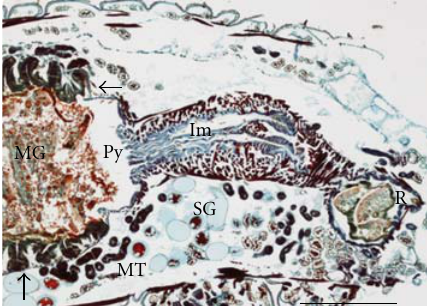
Figure 13: Longitudinal section (dorsal side up) of a N. abietis larva showing folds (arrows) in the epithelium at posterior end of the midgut (MG) and the hindgut showing the pylorus (Py), ileum (Im), and rectum (R). Malpighian tubules (MT) and salivary gland (SG) are visible in the hemocoel. Scale bar =